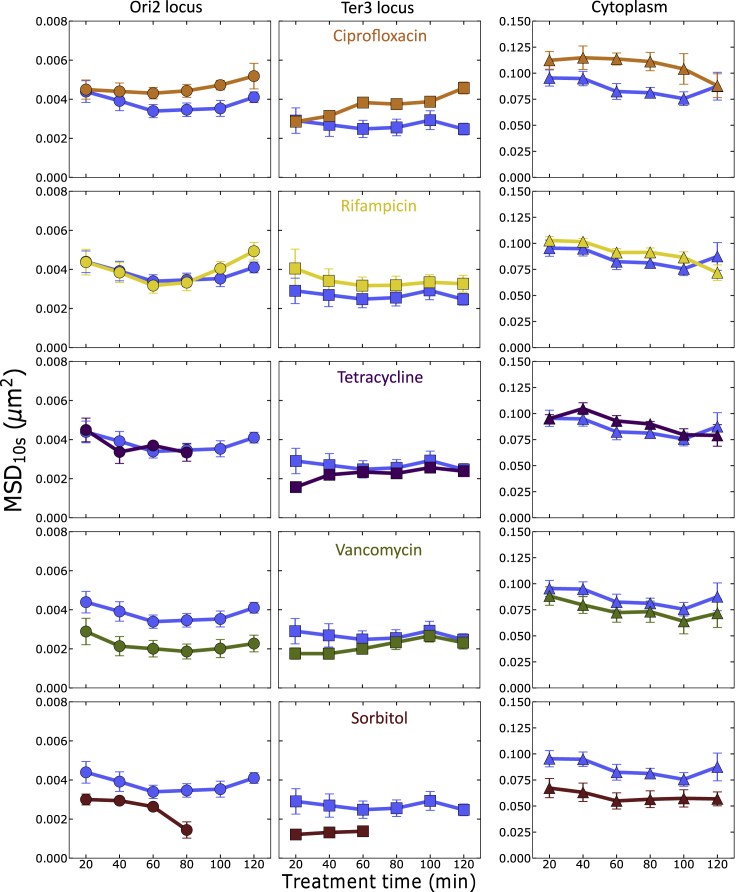
Sub-lethal Antibiotics and Sorbitol Change the Mobility of Both Chromosome and CytosolThere are small but consistent changes to the short timescale mobility MSD(10 s) over treatment time (Ttreat = 20–120 min) for different antibiotics and sorbitol (in different colors as indicated in the figure), compared with control (blue lines) for the marker at the Ori2 locus (circles), the Ter3 locus (squares), and for the cytoplasmic particle (triangles). Data points show the average of the medians from 9 (chromosomal loci) and 6 (particles in cytoplasm) independent replicates. Error bars show the standard error. p Values are given in Table S2 and Supplemental Information.